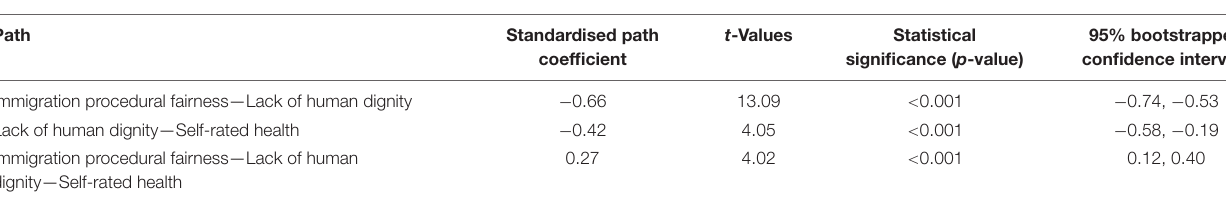
t -Values Statistical 95% bootstrapped coefficient significance ( p -value) confidence